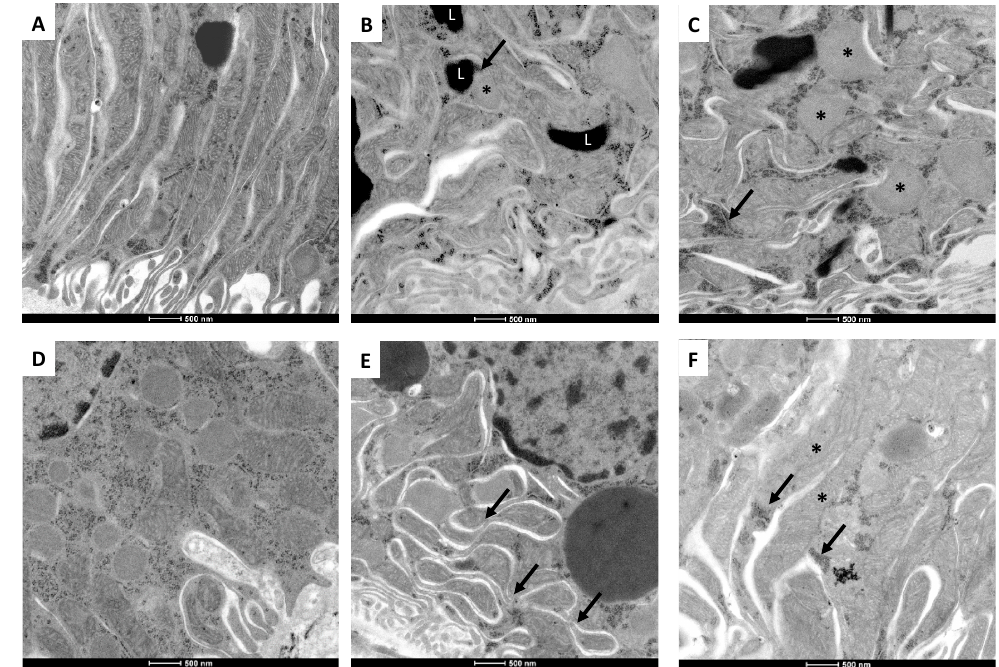
Figure 7. Representative electron microscopy micrographs of mitochondria from tubular epithelial cells at different time points. ( A ) Control Sham animal kidneys show normal mitochondrial structure. ( B ) On day 2 of nephrectomy, mitochondria show cristae effacement and there are numerous lysosomes (L), one small round mitochondria (asterisk) is contacting with a lysosome (mitophagy, arrow). ( C ) More round small mitochondria (asterisks), lysosomes, and numerous free ribosomes (arrow) are seen on day 4 of nephrectomy. ( D ) A similar ultrastructural pattern is observed on day 7 of nephrectomy, some well-preserved mitochondria are surrounded by numerous small round mitochondria with cristae effacement. ( E ) On day 14 of nephrectomy, besides small mitochondria with cristae effacement, many fused mitochondria are also frequent (arrows) and large lysosomes. ( F ) On day 28 of nephrectomy, fused mitochondria are more common, as well as small round mitochondria and cumuli of free ribosomes (arrows).